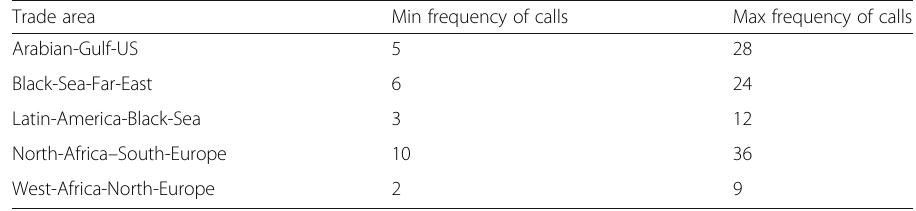
Table 11 Trade areas and their minimum and maximum frequency of calls in 2018 Trade area